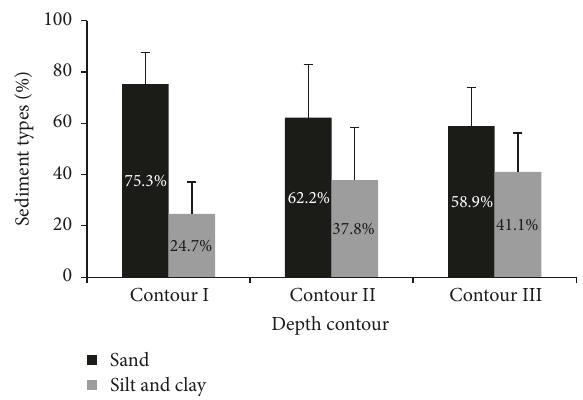
Figure 6: The average percentage of sand and silt/clay of all depth contours.